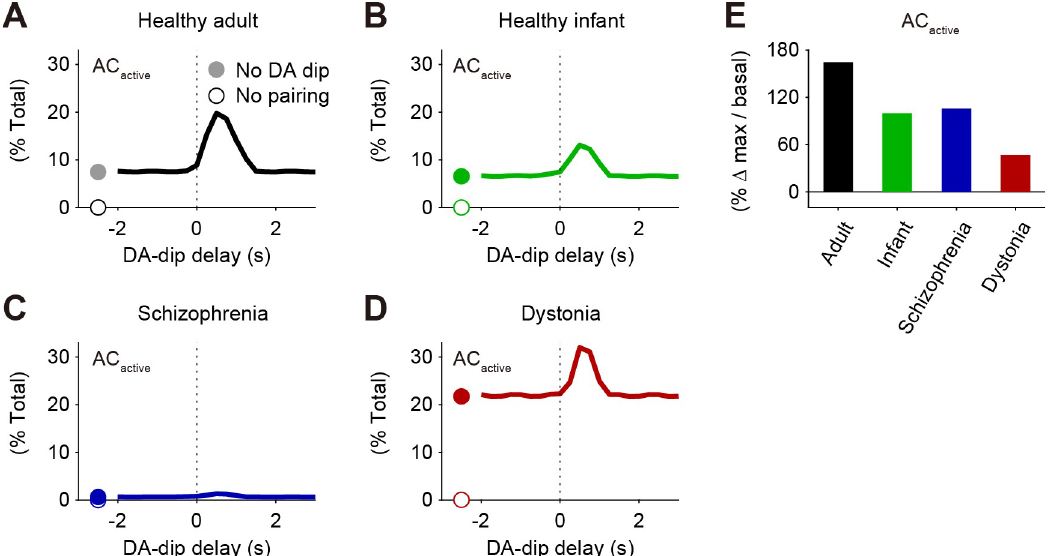
Fig 7. Decreased efficacy of the coincidence detection in pathologic/movement disorders. (A-D) Time windows for DA-dip delay against pre–post pairing on the activity of AC1, [ AC active ], in the models of healthy adult (A), healthy infant (B), schizophrenia (C), and DYT1 dystonia (D). For each DA-di delay, a 0.5-s DA dip is paired with 1-s pre-post pairing. Obtained maximal [ AC active ] are normalized by the total concentrations of AC1, [ AC ] tot . (E) Maximal amplitudes of AC active normalized by the basal